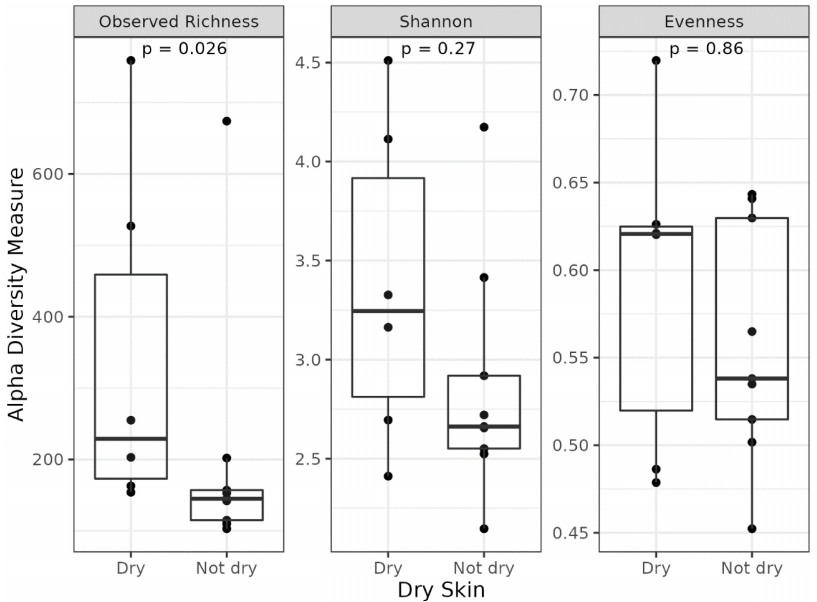
Figure 9. Boxplots reporting alpha diversity indices (Observed Richness, Shannon, and Evenness indices) in dry skin and normal skin groups. P − values less than 0.05 were considered statistically